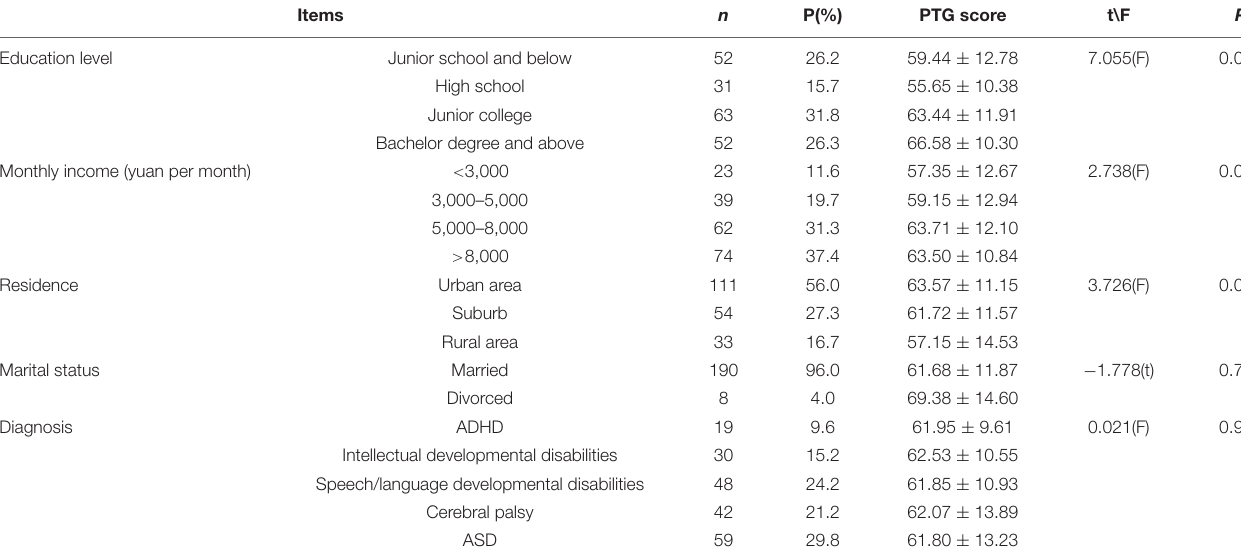
TABLE 2 | Relationship between the social-demographic characteristic and the PTG. Items n P(%) PTG score